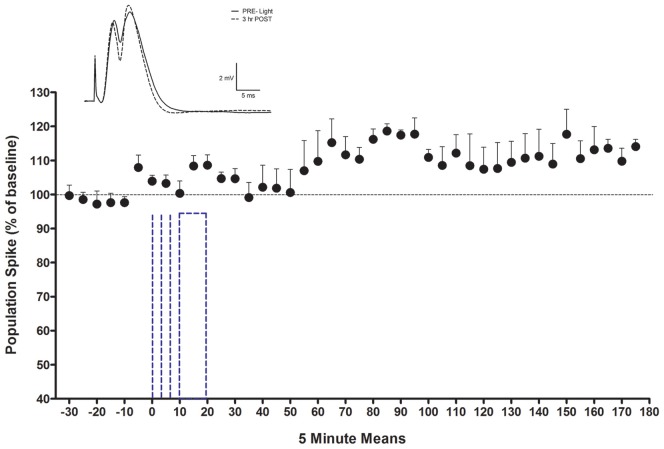
LTP of population spike for LTP rats with consistent waveforms (n = 4). Inset shows an average waveform during baseline and at the end of the potentiation period from one subject. Note absence of EPSP slope change. The dotted lines indicate light activation. The first three denote 5 or 10 s periods and the last denotes the onset and offset of the 10 min activation period. The LC optrode was adjusted to optimize unit recording for light activation prior to 0.